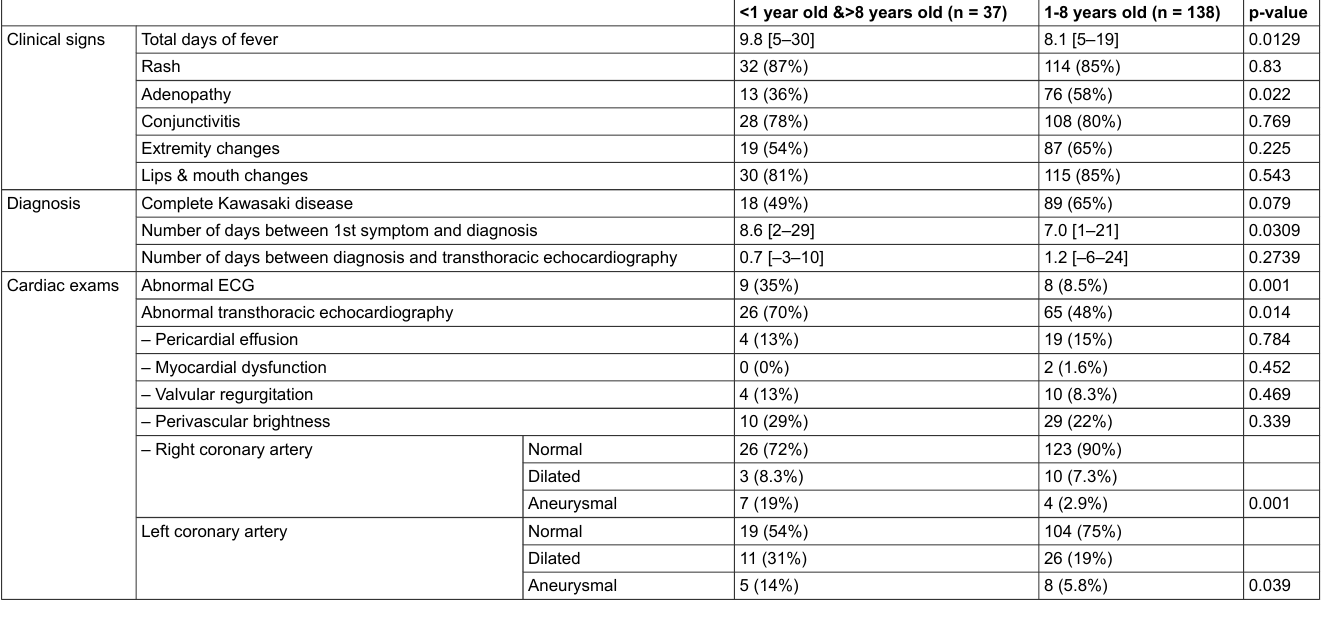
Table 6: Comparison between children at the extreme spectrum of age (defined as <1 year or >8 years) versus typical age (between 1 and 8 years). Continuous variables are expressed as mean [range]. Categorical variables are expressed in absolute numbers